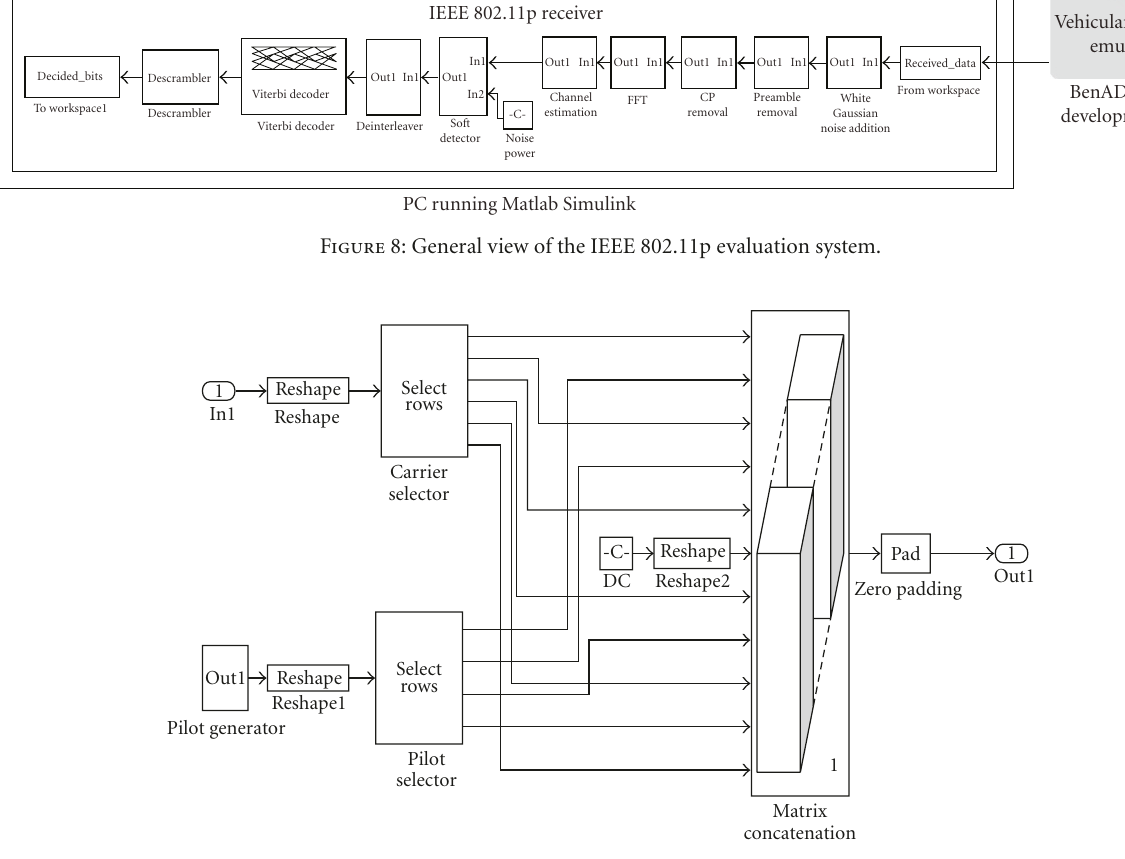
Figure 9: Placement of the DC, data and pilots into the OFDM symbol